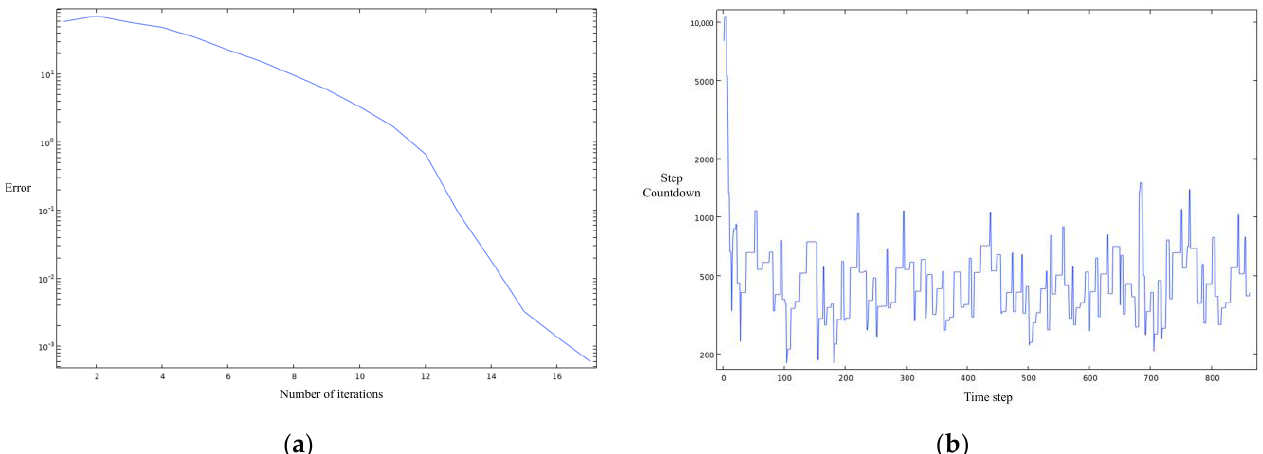
Figure 4. ( a ) Steady − state solver; ( b ) transient solver. Figure 4. ( a ) steady–state solver; ( b ) transient